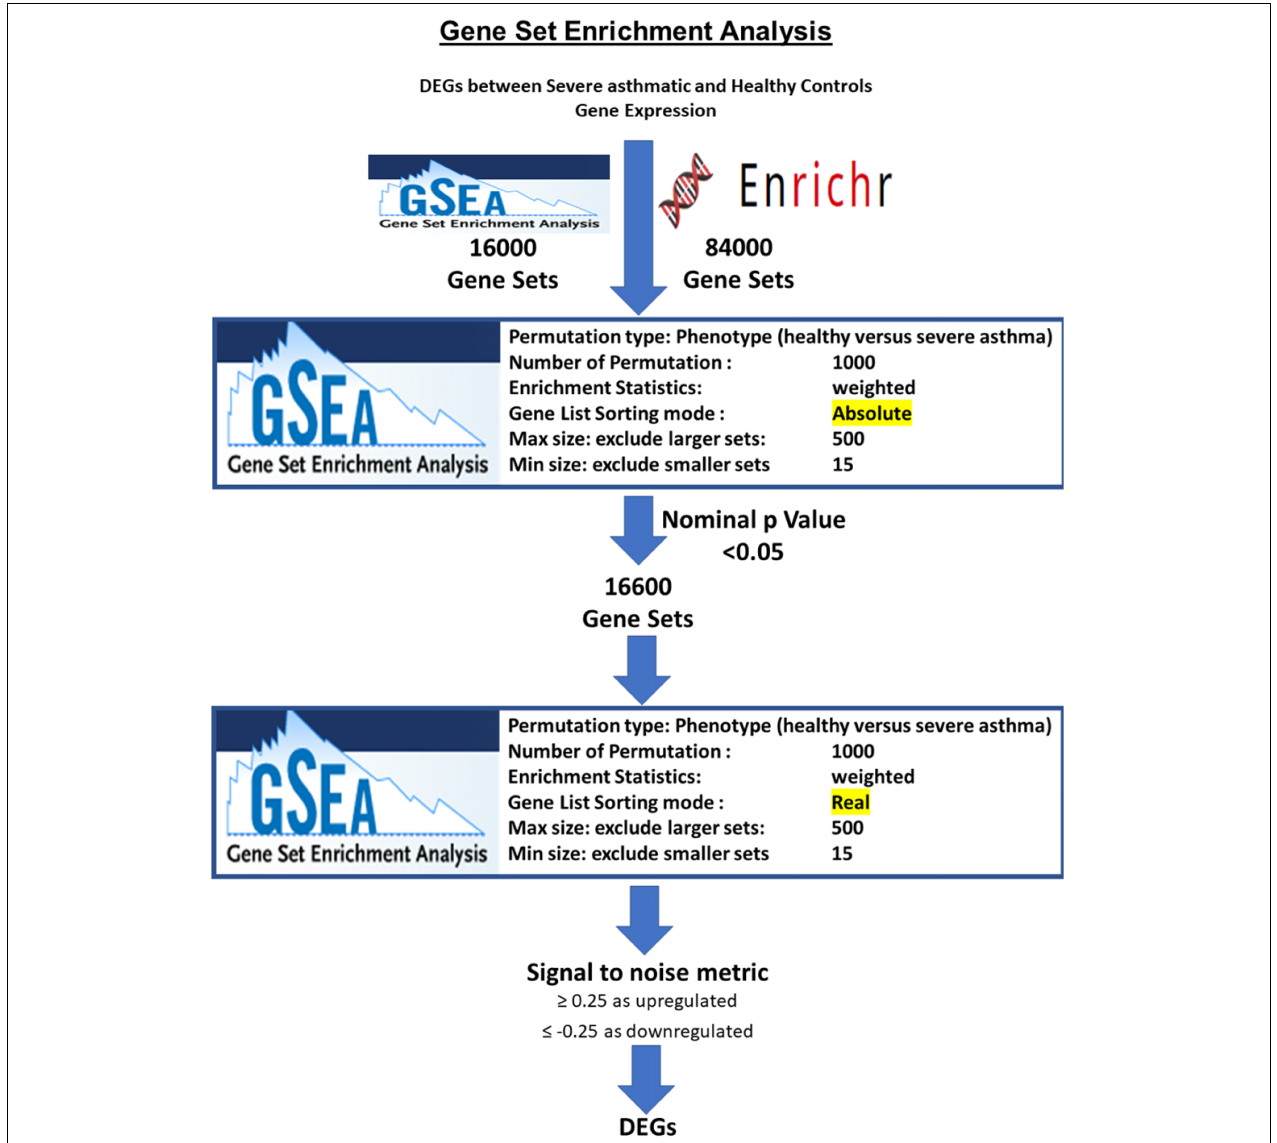
FIGURE 1 | Flowchart for identification of DEGs in severe asthmatic versus healthy controls based on the number of pathways that they are enriched in by the AbsGSEA and GSEA